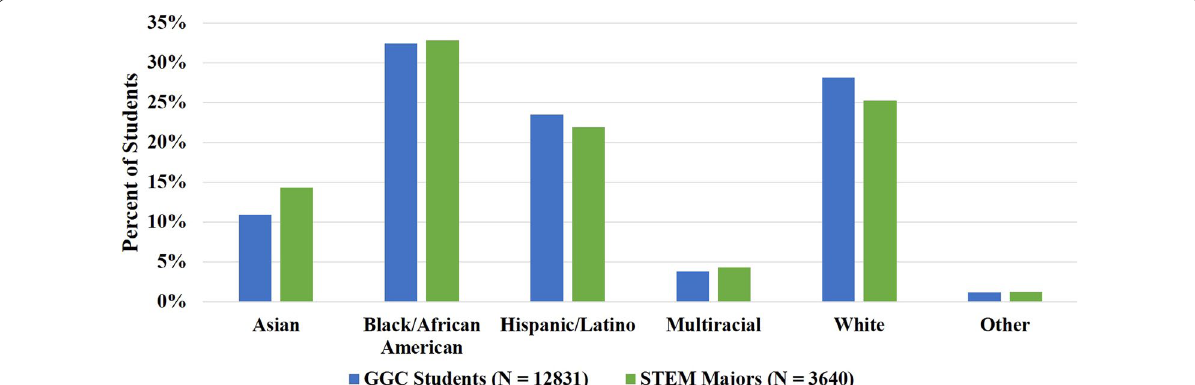
Fig. 1 Self‑identified racial and ethnic demographic distributions of all GGC students ( N GGC ( N 3640) in Fall =